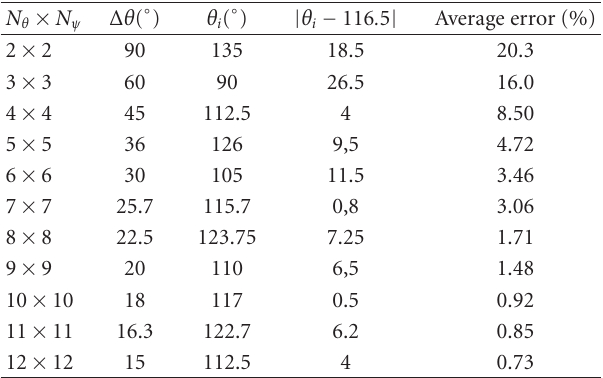
Table 1: E ff ect of the number of directions on the accuracy of the